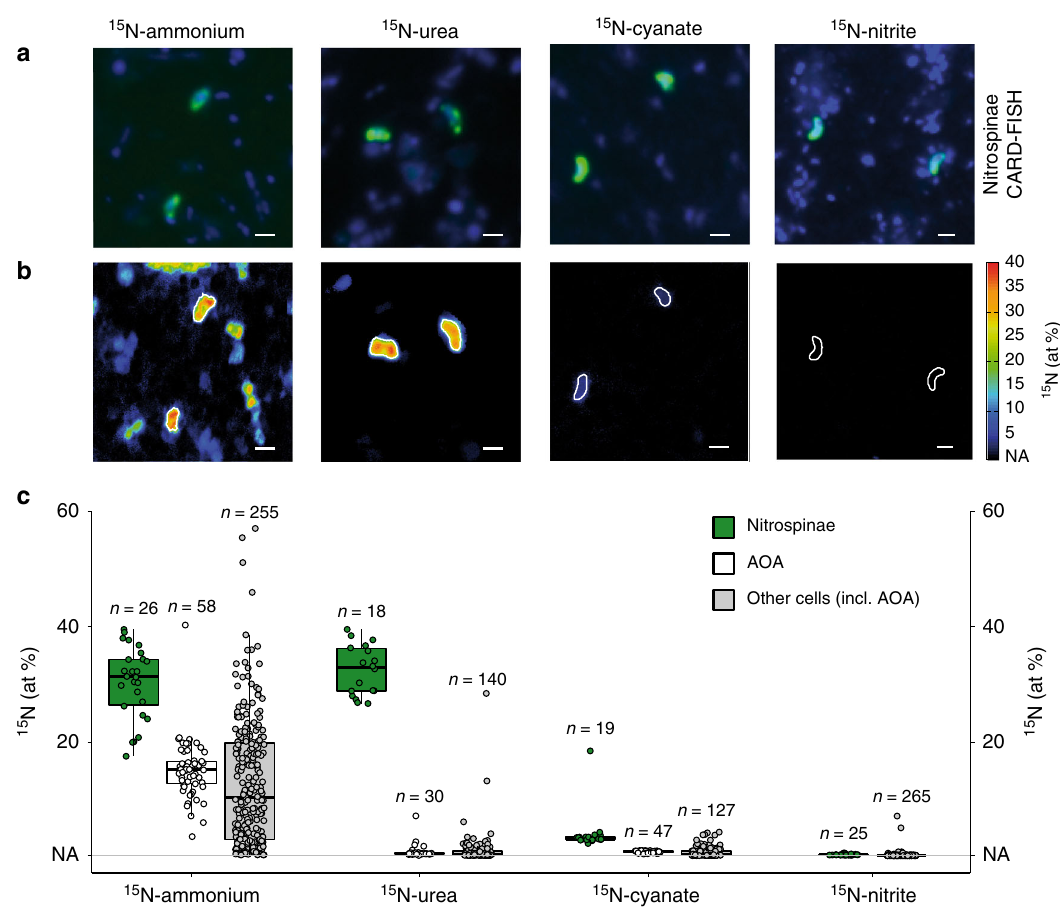
Fig. 5 Nitrospinae single cell 15 N-assimilation from ammonium, urea, cyanate and nitrite measured by nanoSIMS. a Representative CARD-FISH images of Nitrospinae (green, stained by probe Ntspn759) and other cells (blue, stained by DAPI). b Corresponding nanoSIMS image of 15 N at% enrichment after addition of 15 N-ammonium, urea, cyanate or nitrite. Nitrospinae are marked by white outlines. Scale bar is 1 μ m in all images. c 15 N at% enrichment of Nitrospinae (green), AOA (white) and other, non-targeted cells (gray) after incubation with 15 N-ammonium, 15 N-urea, 15 N-cyanate or 15 N-nitrite. AOA data were taken from Kitzinger et al. 31 for comparison. Note that non-targeted cells depicted here also include AOA cells, as no speci fi c AOA probe was included in the Nitrospinae nanoSIMS measurements. Number of cells analyzed per category is indicated above each boxplot. Boxplots depict the 25 – 75% quantile range, with the center line depicting the median (50% quantile); whiskers encompass data points within 1.5x the interquartile range. NA is the natural abundance 15 N at% enrichment value